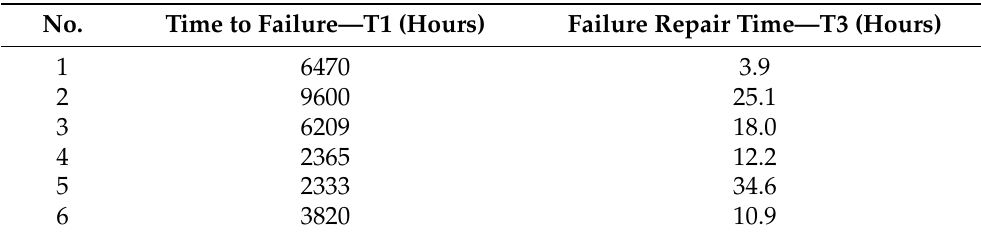
Figure 6. Coal mill feeder T3 time to repair from failure ( left ) and T4 time to repair from dam- age ( right ) represented by lognormal probabilistic distributions, where red dots are empirical data obtained for each event; N is the number of obtained data; AD is the value of Anderson–Darling statis- tical test; and the P -value is a measure how well the data follow the obtained lognormal distribution. In a similar manner, statistical analysis was carried out for the falling pipe. The data gathered for the falling pipe during plant operation are shown in Tables 3 and 4. However, were omitted. Table 3. Empirical data for the coal mill falling pipe used in the statistical analysis of failures and the time needed for their repair.